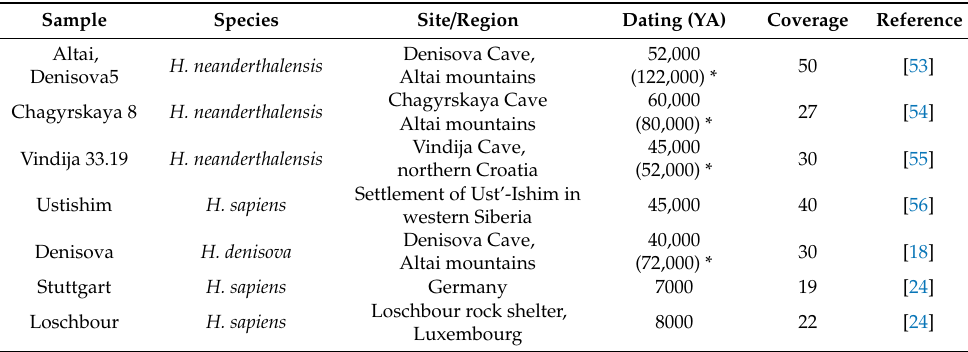
Table 6. Characteristics of ancient DNA samples from prehistoric